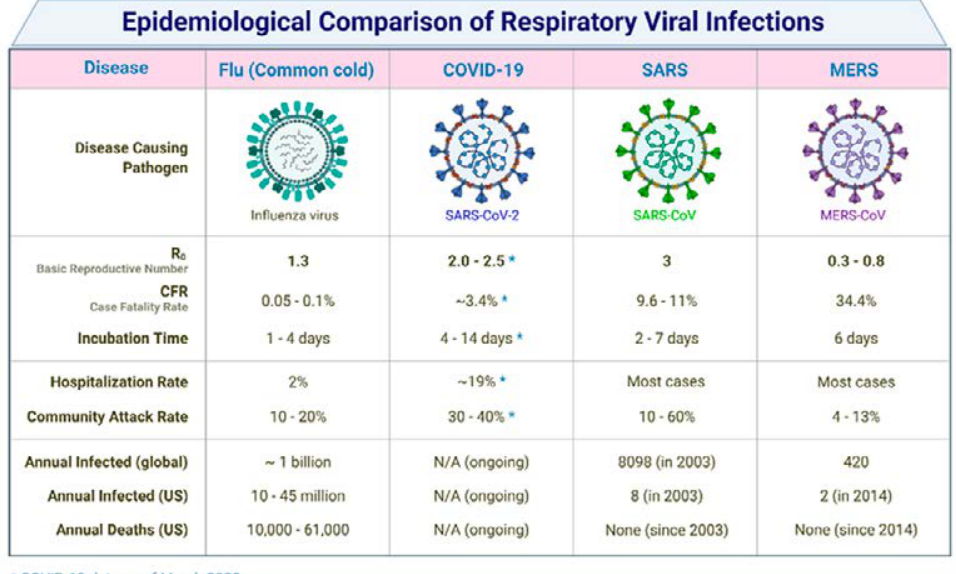
Fig. 1. A schematic representation of an epidemiological comparison of respiratory viral infections. The Figure was created with the “BioRender.com” template and exported under the terms of premium